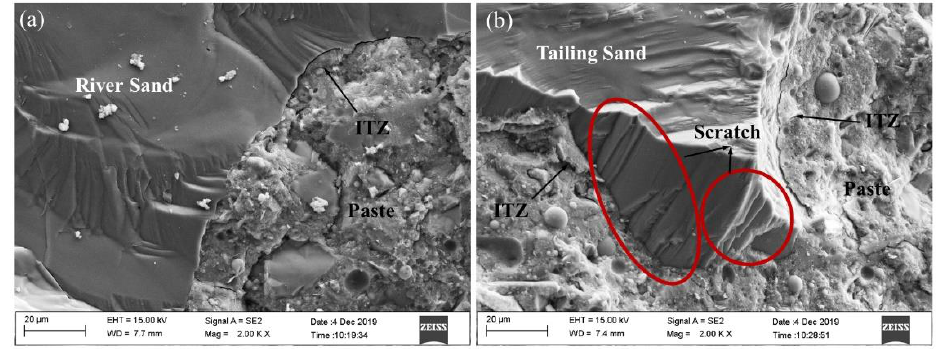
Figure 14. SEM images of ITZ. ( a ) river sand ( b ) iron tailing sand.